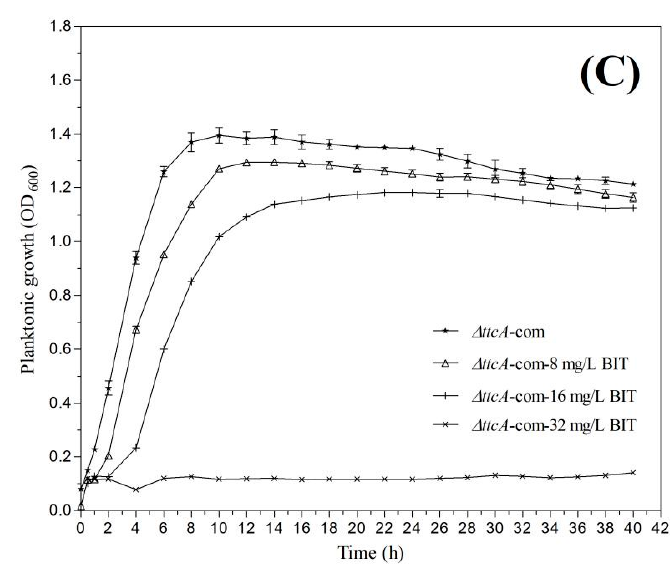
Figure 3. Growth curves of C. werkmanii BF-6 ( A ), Δ ttcA ( B ) and Δ ttcA -com ( C ). The strains were cultivated in LB medium supplemented with 0, 8, 16 or 32 mg/L BIT and incubated at 30 °C for 40 h.